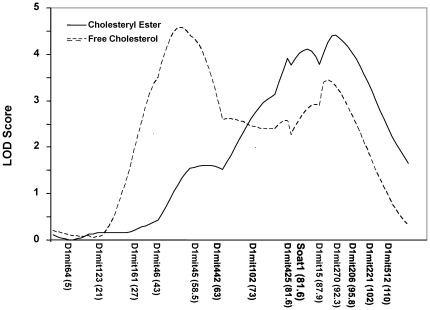
LOD score plots for esterified and free cholesterol levels on chromosome 1.The x-axis depicts the marker positions in centimorgans, and the y-axis depicts the LOD score. The microsatellite markers typed are listed below the x-axis, corresponding to their map locations on the chromosome.